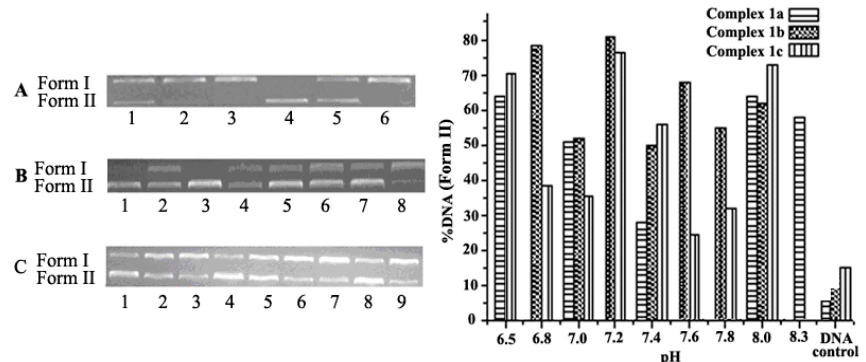
Figure 3. Histograms and electropherograms (the right side figure) representing cleavage of pUC19 plasmid DNA (0.008 µg/µL) in different pH buffer of 1a (6.25 × 10 − 7 mol/L), 1b (3.13 × 10 − 6 mol/L) and 1c (6.25 × 10 − 7 mol/L) (5 mM Tris-HCl/10 mM NaCl) at 37 °C for 6 h. ( A ) Complex 1a ; Lanes 1 − 5: pH = 6.5, 7.0, 7.4, 8.0, 8.3, Lane 6 = DNA control, respectively; ( B ) Complex 1b; Lanes 1–7: pH = 6.8, 7.0, 7.2, 7.4, 7.6, 7.8, 8.0; Lane 8 = DNA control, respectively; ( C ) Complex 1c; Lanes 1–8: pH = 6.5, 6.8, 7.0, 7.2, 7.4, 7.6, 7.8, 8.0; Lane 9 = DNA control, respectively.